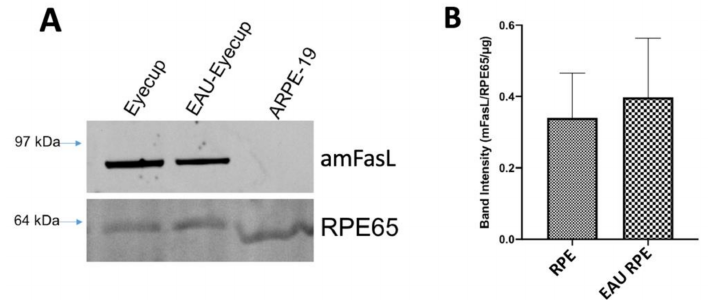
Figure 3. Expression of mFasL in RPE ESMs. ( A ) Immunoblot analysis for FasL was done on the isolated ESMs from RPE eyecups of naive and EAU eyes (Eyecup, EAU-Eyecup), and from the confluent cultures of ARPE-19 cells (ARPE-19). Bands that correspond with aggregated mFasL (amFasL) were detected in the ESMs from the RPE eyecups of healthy and EAU eyes and not from the ARPE-19 ESMs. Presented is a representative of 4 immunoblots. No FasL band was detected or measured in any EV from the culture supernatant of confluent ARPE-19 cells. ( B ) In all the ESMs, RPE65 was detected and used as a loading control along with the amount of protein loaded to measure the relative expression of the amFasL band intensity between the ESMs from naive (RPE) and EAU (EAU RPE) eyecups. Presented is the mean ± SEM of 4 independent experiments. There were no statistical differences between healthy and EAU EV expression of mFasL. The ESMs from RPE express